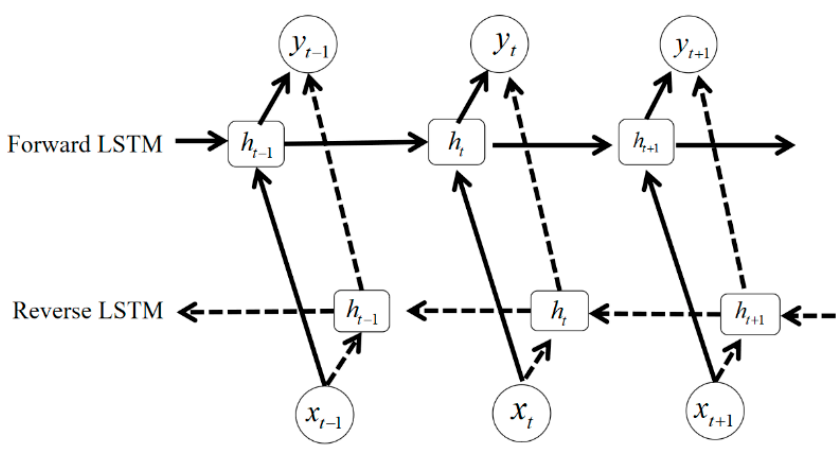
Figure 4. Bi-LSTM network structure based on LSTM.